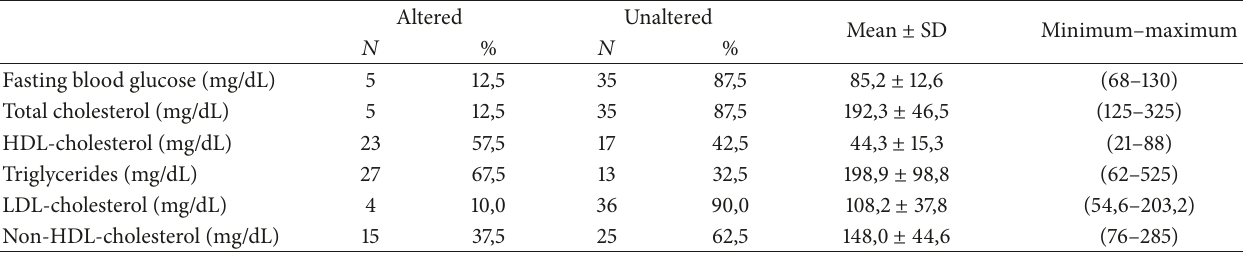
Table 1: Alteration frequency, average values, and minimum and maximum values for glycemic and lipid profile of people living with HIV/AIDS with clinical HIV-associated lipodystrophy syndrome diagnosis.